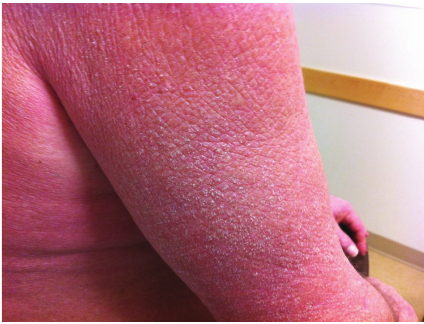
Figure 3: Cutaneous mucinosis: diffuse, scaly, and erythematous rash with white macules.